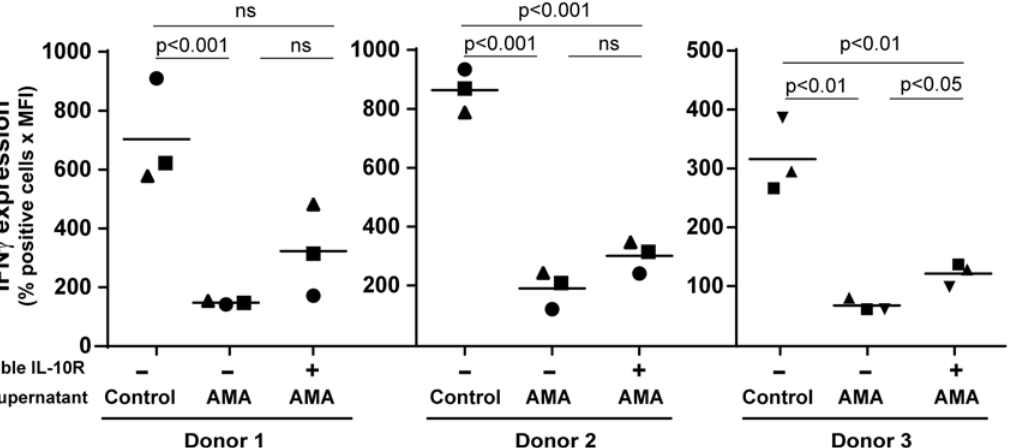
Fig 9. Parasite-mediated modulation of IFN γ secretion by CD4+ T-cell relies in part on IL-10. Purified human CD25 - CD4 + T cells were activated for 72 h with plate-bound anti-CD3 and anti-CD28 antibodies in the presence of cell-free supernatants from B cells either left untreated (control) or incubated overnight with L . infantum amastigotes at a final parasite:host cell ratio of 3:1 (AMA). In some cases, cell-free supernatants from B cells incubated with parasites were treated with a soluble IL-10 receptor (1 μ g/ml) before being used with activated CD25 - CD4 + T cells. During the last 5 h of incubation, cells were further stimulated with PMA (50 ng/ml) and ionomycin (1 μ g/ml) and Golgiplug ™ was added (1 μ l per 1 x 10 6 cells). Finally, cells were fixed, permeabilized and stained for intracellular IFN γ before being analysed by flow cytometry. Dead cells were excluded by 7-AAD staining. Results are expressed as the percentages of TNF-positive cells multiply by the mean fluorescence intensities (MFI). Data shown are the results from 3 different CD25 - CD4 + T-cell donors incubated with cell-free supernatants from 3 different B-cell donors. Statistical significance was evaluated by two-tailed Student ’ s t-